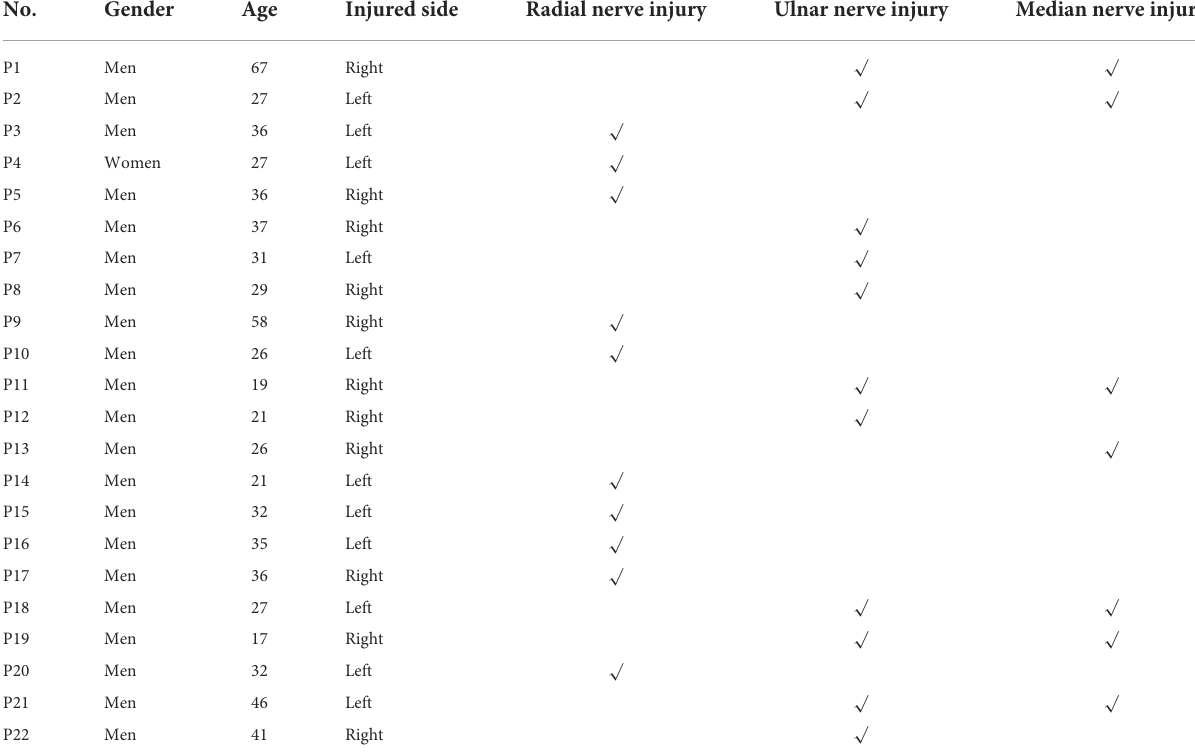
TABLE 3 Characteristics of the